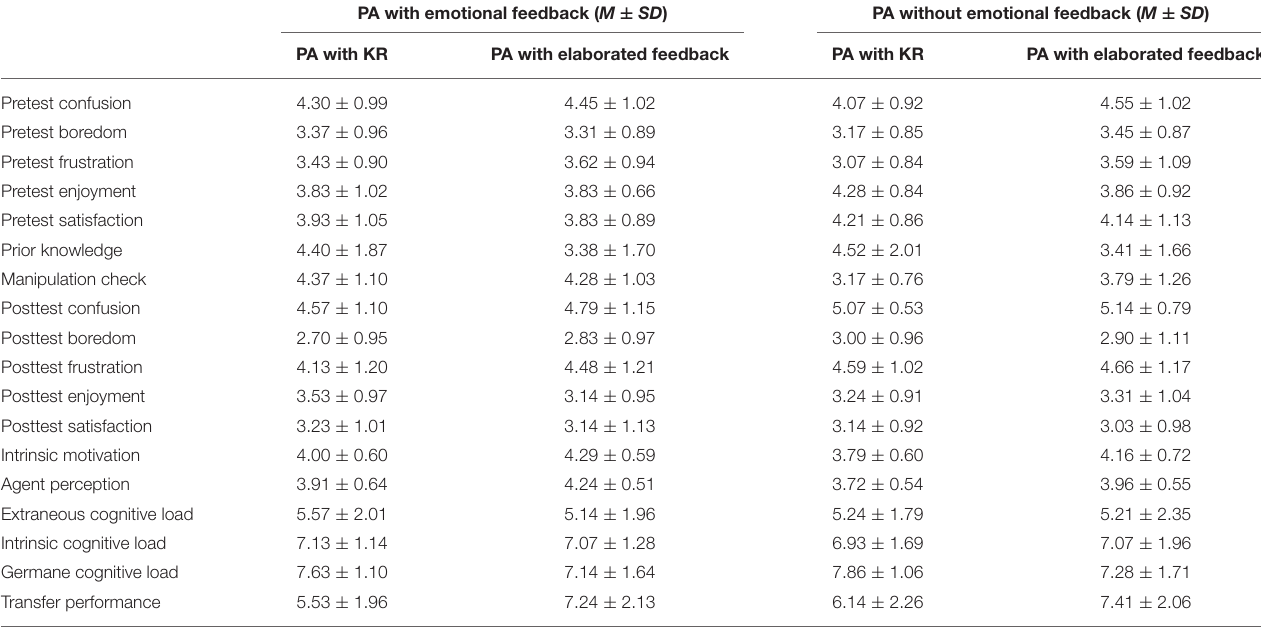
TABLE 3 | Means and standard deviations of all variables. PA with emotional feedback ( M ± SD ) PA without emotional feedback ( M ± SD ) PA with elaborated